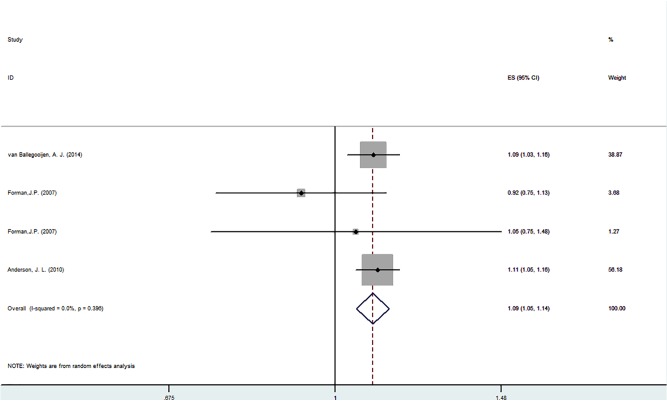
Forest plot for vitamin D sufficient VS normal.Hazard ratios of hypertension of the normal versus sufficient category of blood 25(OH)D concentration. CI indicates confidence interval. The size of each square is proportional to the study’s weight.